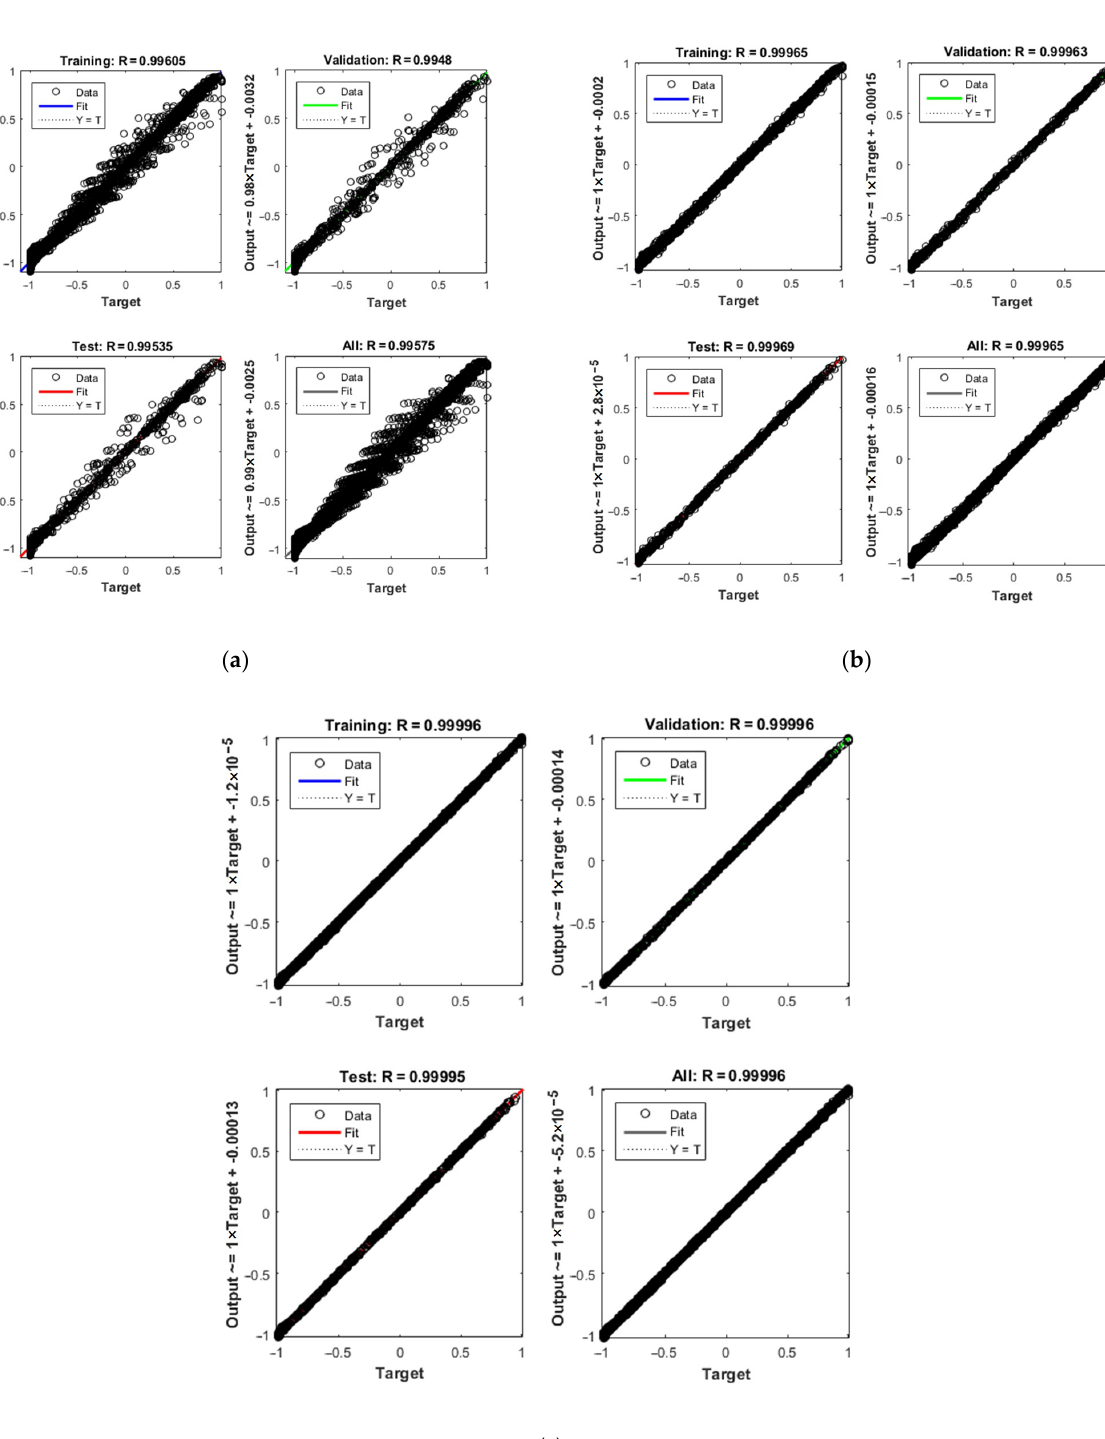
Figure 5. Regression performances of the training process with different numbers of neurons: ( a ) 3 × 3; ( b ) 3 × 6; ( c ) 6 ×